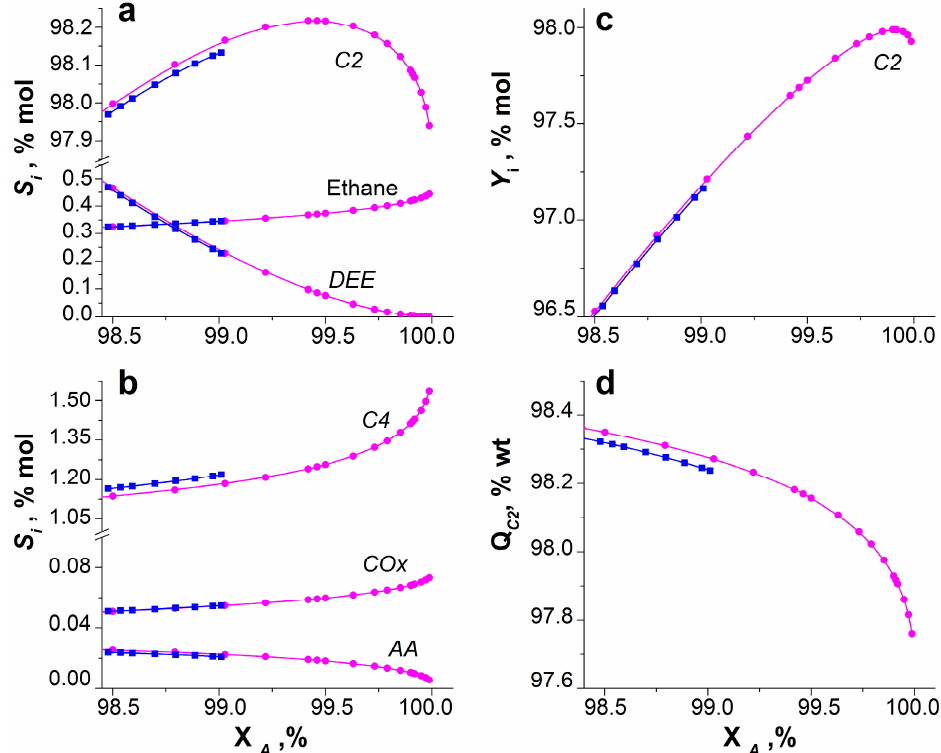
Figure 6. Selectivity S i ( a , b ), yield Y C 2 ( c ), and C2 fraction in dry-ethylene Q C 2 ( d ) vs. conversion X A Figure 6. Selectivity 𝑆 Figure 6. Selectivity 𝑆 (cid:3036) ( a , b ), yield 𝑌 (cid:3004)(cid:2870) ( c ), and C2 fraction in dry ‐ ethylene 𝑄 (cid:3004)(cid:2870) ( d ) vs. conversion Figure 6. Selectivity 𝑆 (cid:3036) ( a , b ), yield 𝑌 (cid:3004)(cid:2870) ( c ), and C2 fraction in dry-ethylene 𝑄 (cid:3004)(cid:2870) ( d ) vs. conversion (cid:3036) ( a , b ), yield 𝑌 (cid:3004)(cid:2870) ( c ), and C2 fraction in dry-ethylene 𝑄 (cid:3004)(cid:2870) ( d ) vs. conversion 𝑋 (cid:3002) in MTR under diffusion ‐ controlled conditions. Conditions in Table 3: #1 ( ), #2 ( ). 𝑋 (cid:3002) in MTR under diffusion-controlled conditions. Conditions in Table 3: #1 ( ), #2 ( ). 𝑋 (cid:3002) in MTR under diffusion-controlled conditions. Conditions in Table 3: #1 ( ), #2 ( ). Table 3. Dehydration of pure 92% ethanol in MTR over proprietary 6mm ring ‐ shaped alumina cat ‐ Table 3. Dehydration of pure 92% ethanol in MTR over proprietary 6mm ring-shaped alumina cat- Table 3. Dehydration of pure 92% ethanol in MTR over proprietary 6mm ring-shaped alumina cat- alyst. alyst.